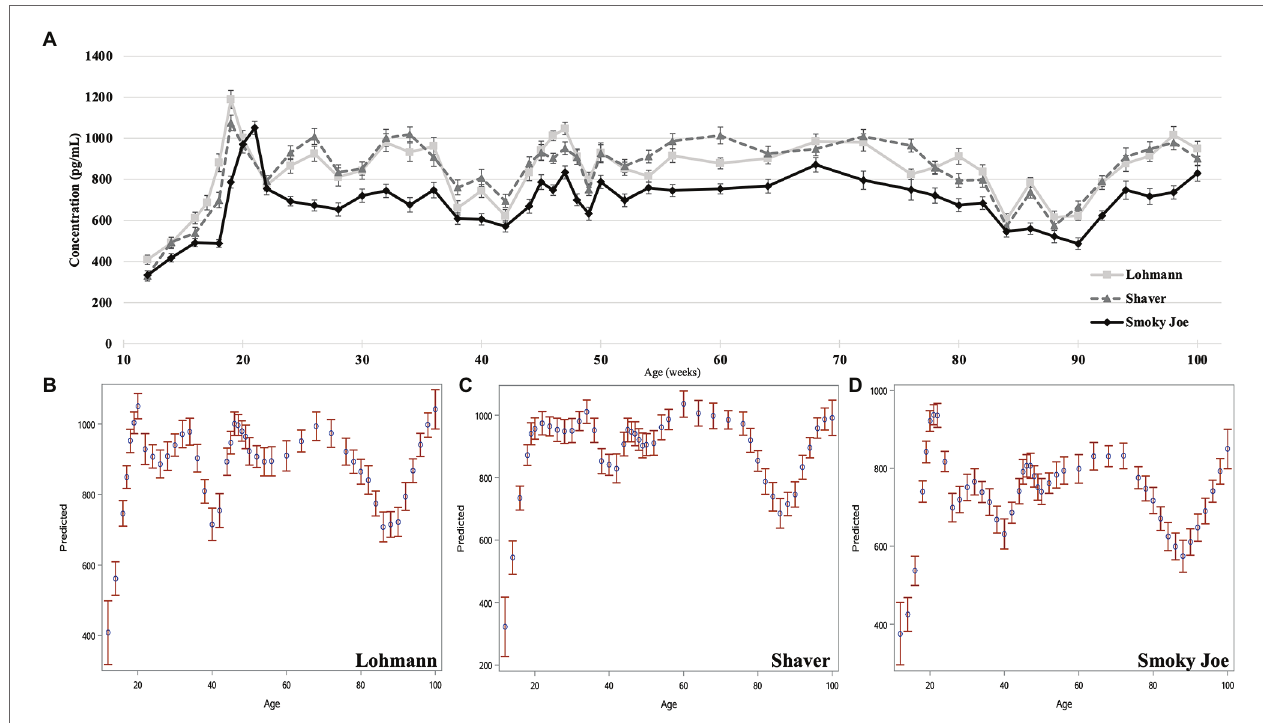
FIGURE 3 | Estradiol concentration of Lohmann, Shaver, and Smoky Joe hens from 12 to 100 woa. (A) Average E 2 concentration per strain ± SEM. Predicted smoothed curve for Lohmann (B) , Shaver (C) , and Smoky Joe (D) hens ±95% CI.